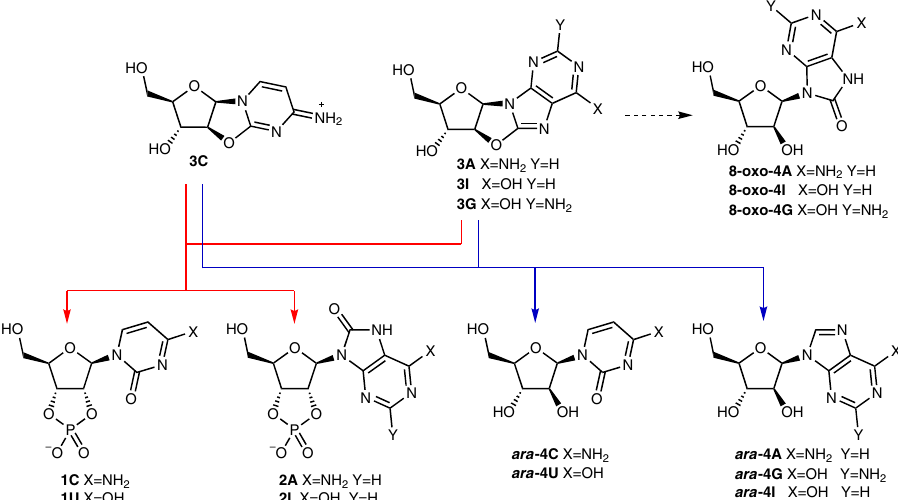
Fig. 1 Divergent prebiotic nucleotides synthesis. Red arrows: Previous work; a prebiotic pathway to cytidine-2 ′ ,3 ′ -cyclic phosphate ( 1C ), uridine-2 ′ ,3 ′ -cyclic phosphate ( 1U ), 8-oxo-adenosine-2 ′ ,3 ′ -cyclic phosphate ( 2A ) and 8-oxo-inosine-2 ′ ,3 ′ -cyclic phosphate ( 2I ) 16,22 . Dashed arrow: Hydrolysis of 8,2 ′ - anhydropurines ( 3A , 3I and 3G ) is not observed, which provides chemical differentiation from 2,2 ′ -anhydropyrimidine ( 3C ) that readily hydrolyses to β - arabino -adenosine ( ara -4C ). Blue arrows: This work; a prebiotic pathway to β - arabino -cytidine ( ara -4C ), β - arabino -uridine ( ara -4U ), β - arabino -adenosine ( ara -4A ), β - arabino -inosine ( ara -4I ) and β - arabino -guanosine ( ara -4G